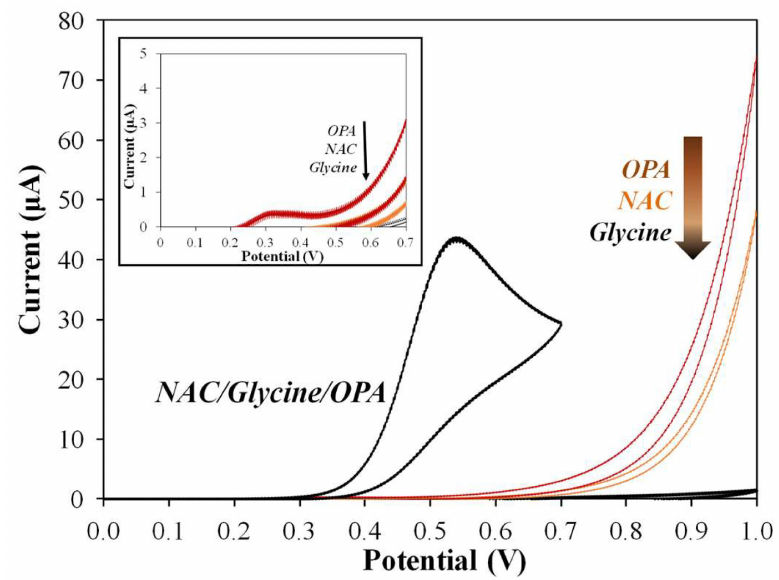
Figure 2. Cyclic voltammograms of glycine (5 mM), NAC (5 mM), OPA (0.1%), and their mixtures were measured using bare SPCEs in 0.1 M PBS (pH 7.0) via cyclic voltammetry with a scan rate of 100 mV/s. The applied potential was measured relative to Ag/AgCl. A zoom-in diagram was included to show the output range of 0–5 µ